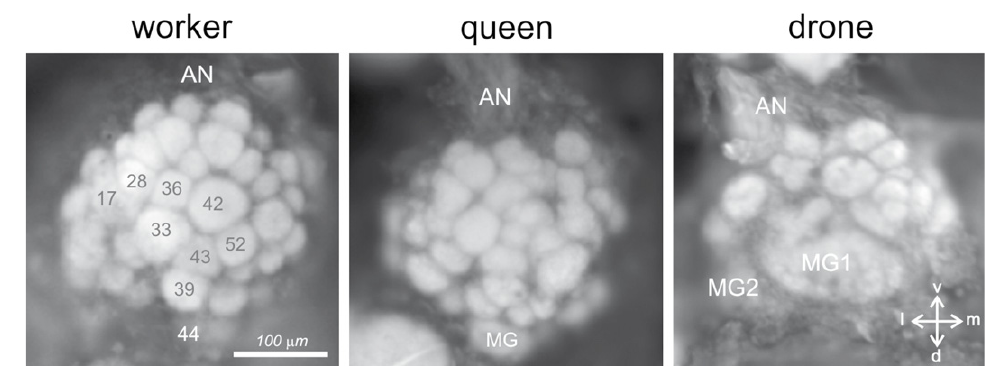
Figure 4. Anatomy of the antennal lobe in the three honeybee castes. Anatomical staining (4% neutral red) of the left antennal lobes of a worker (left), a queen (middle) and a drone (right). The lobes are shown in frontal view, in the position in which they can be accessed during calcium imaging recordings. About 1/4 of the antennal lobe is thus accessible (30–40 glomeruli in workers). AN: antennal nerve; MG: macroglomerulus; v: ventral; l: lateral; m: medial; d: dorsal. Numbers in workers refer to identifi ed glomeruli of the T1 ORN